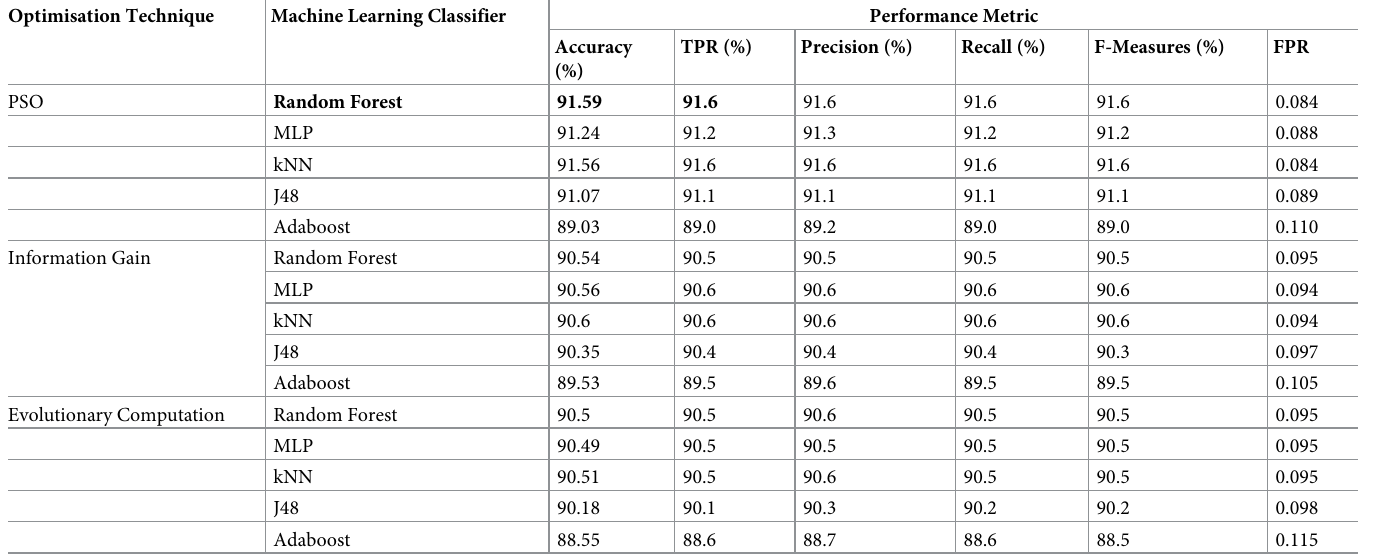
Table 9. Results of detection performance.